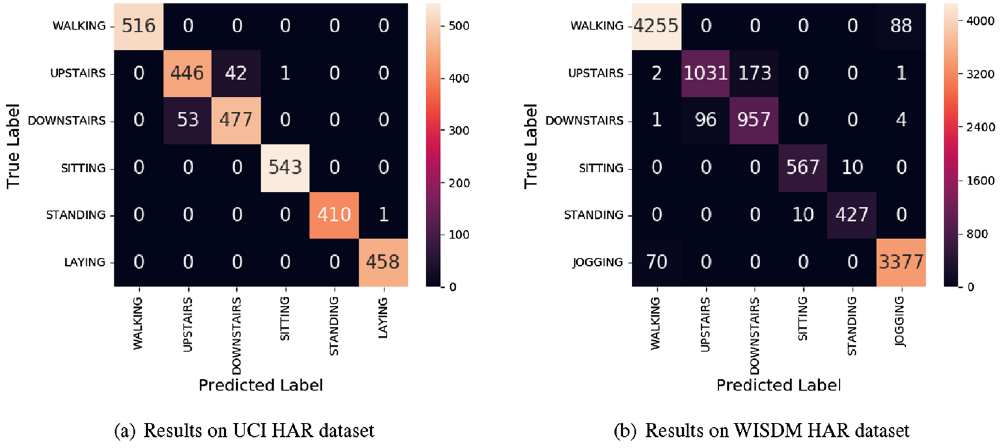
Figure 12. The heatmap of classification of the ConvBLSTM-PMwA